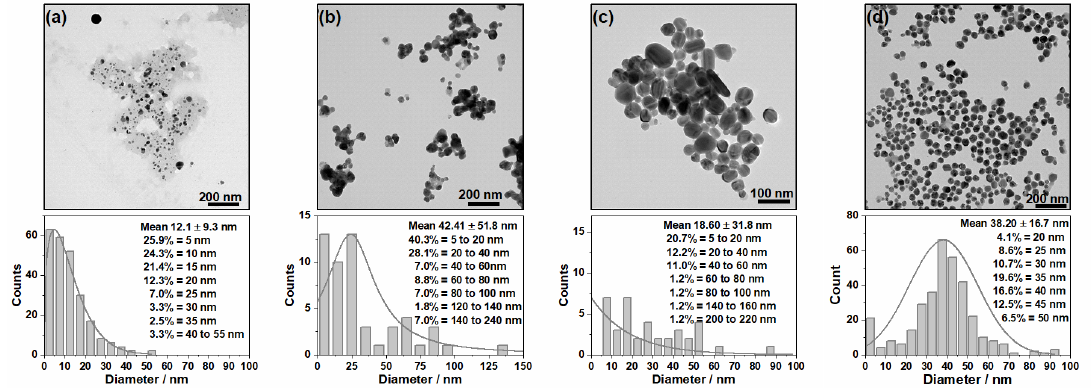
Figure 2. TEM images (above) and histogram distribution (below) for the different synthesized NPs: ( a ) Ag@BH, ( b ) Ag@HX, ( c ) Ag@Citr and ( d ) Ag@βCD3.